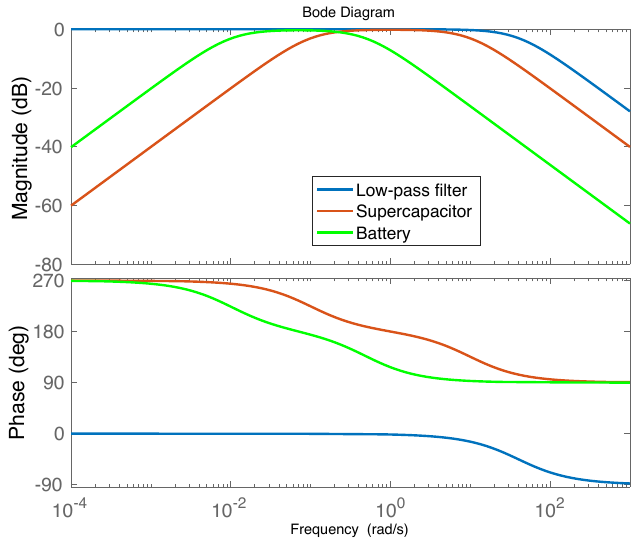
Figure 7. Bode diagram.